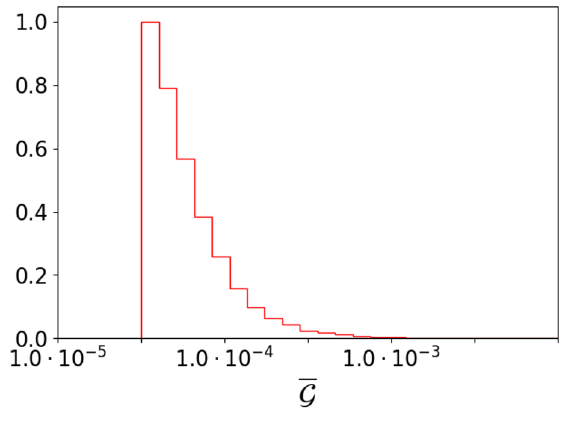
Figure 8 . Distribution of the geometric mean value G of the coupling elements defined in eq. (5.1).